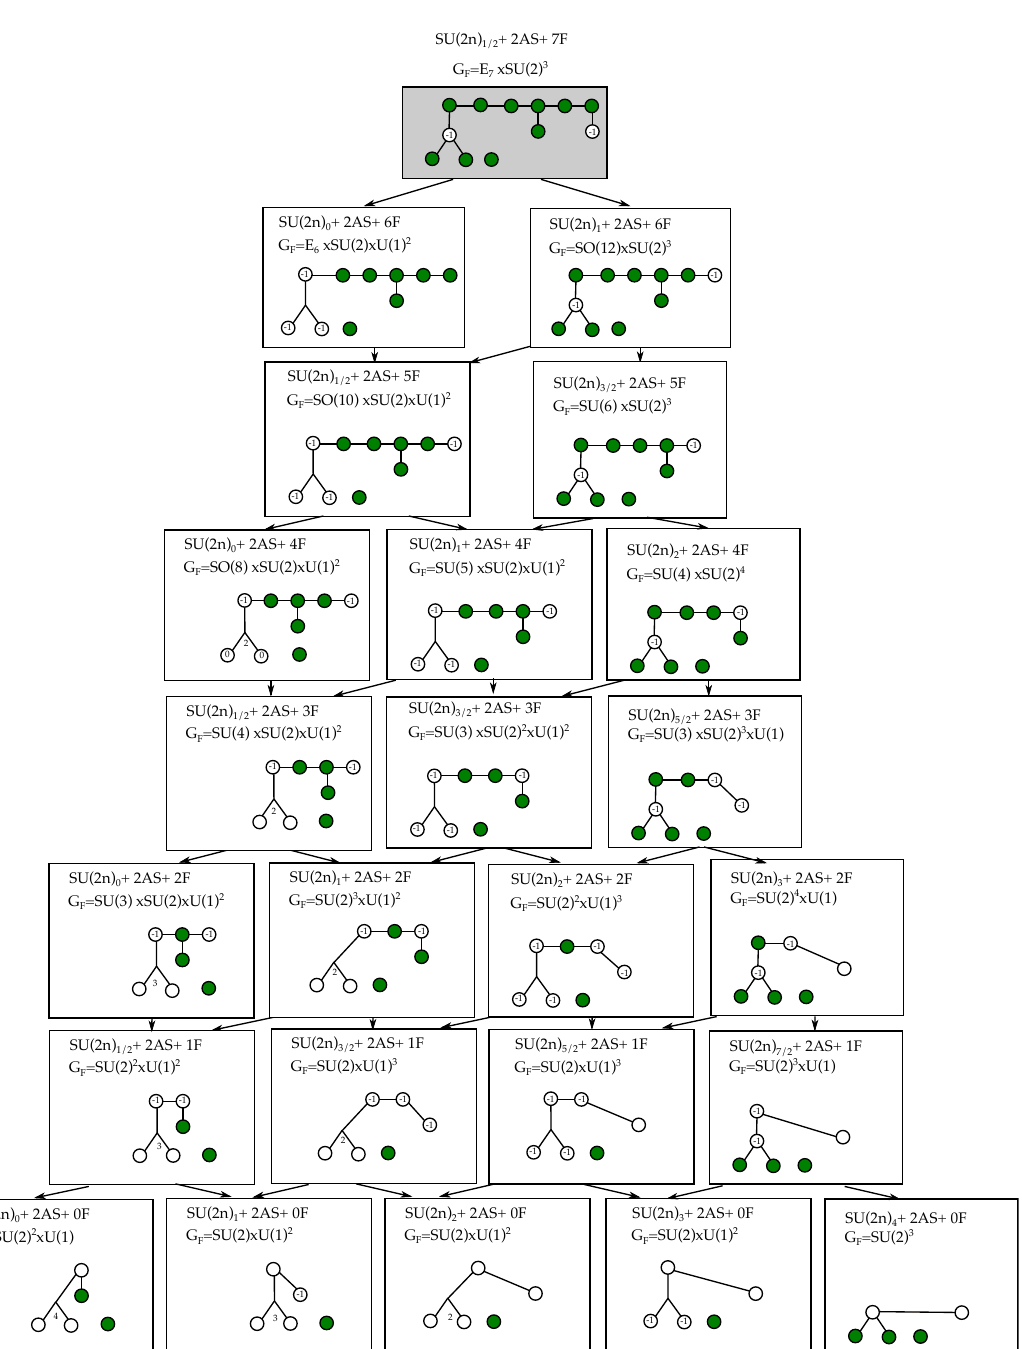
Figure 18. CFD-tree consistent with the decoupling of fundamental (cid:13)avors of SU(2 n ) 0 +2 AS +8 F . The gauge theory descriptions and superconformal (cid:13)avor symmetry G F are labeled.